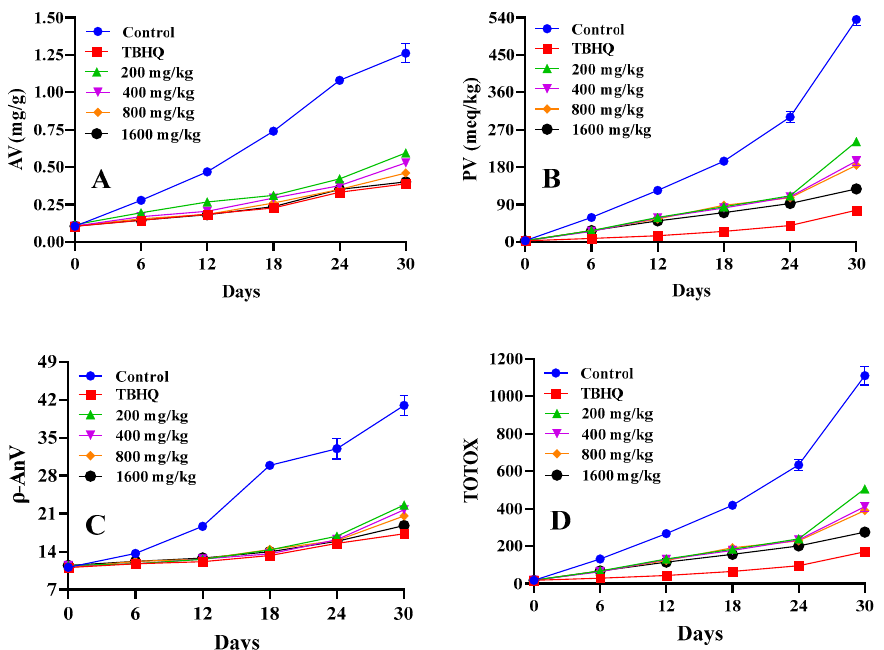
Figure 2. The influences of HCEO on AV ( A ), PV ( B ), ρ -AnV ( C ) and TOTOX ( D ) of sunflower oil samples during the accelerated storage. Values are expressed as means ± SD ( n = 10). (Control) sun- flower oil added with nothing. (TBHQ) sunflower oil added with TBHQ at 200 mg/kg, (200 mg/kg) sunflower oil added with HCEO at 200 mg/kg, (400 mg/kg) sunflower oil added with HCEO at 400 mg/kg, (800 mg/kg) sunflower oil added with HCEO at 800 mg/kg, (1600 mg/kg) sunflower oil added with HCEO at 1600 mg/kg. AV, acid value, PV, peroxide value, ρ -AnV, ρ -anisidine value, TOTOX, Total oxidation value.